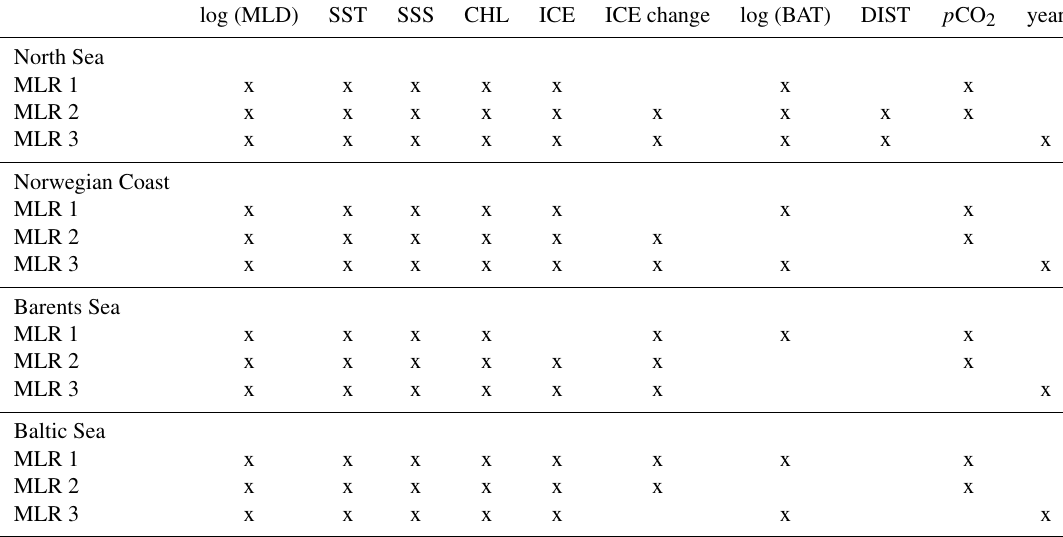
Table 4. Driver used in the different regressions. log (MLD) SST SSS